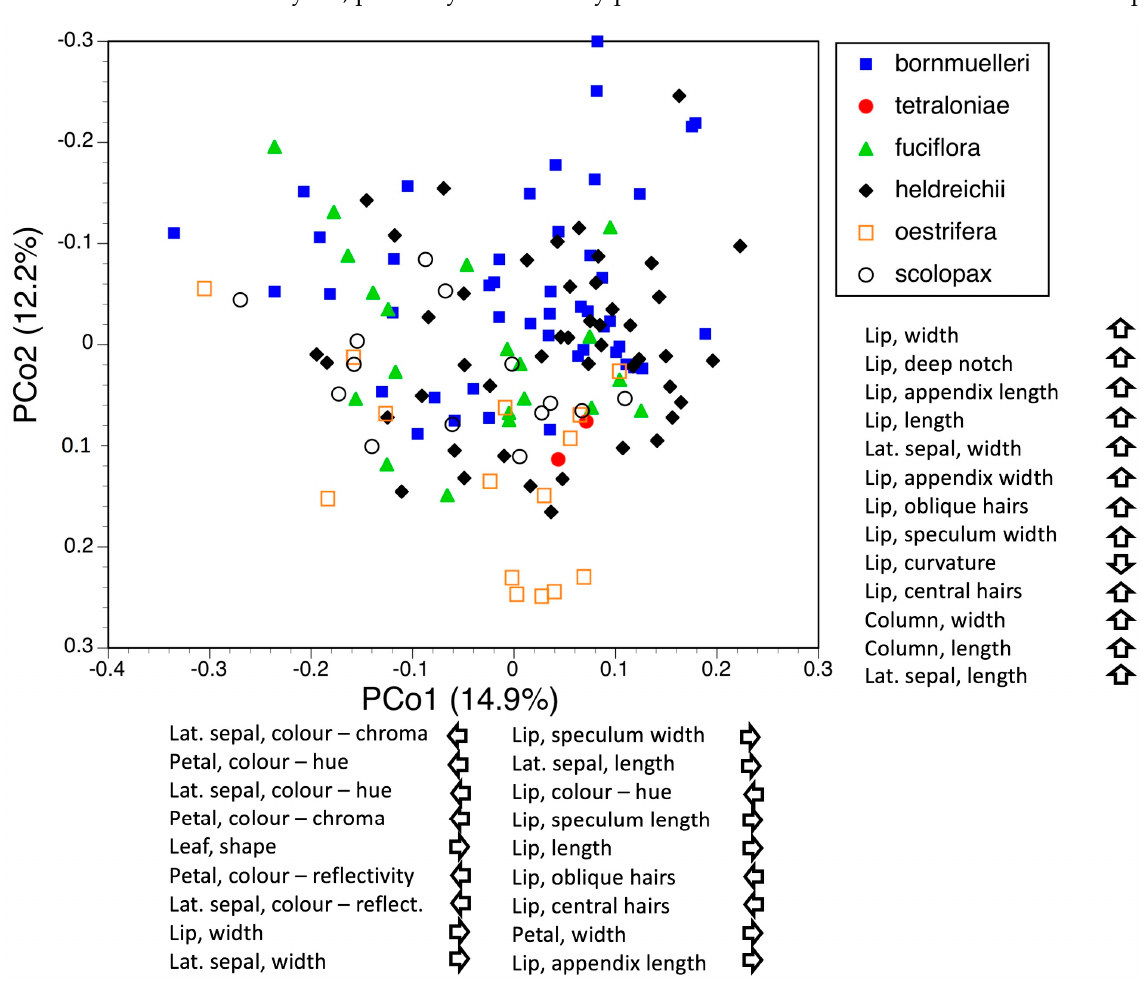
Figure 8. Plot of principal coordinates 1 and 2 for the macrospecies Fuciflora, labelled according to six mesospecies groups: 143 individuals from 68 localities and 51 variable characters. Characters contributing to each coordinate are listed in descending order, with arrows indicating the direction of increase in the value of each character (see also Figure 16).